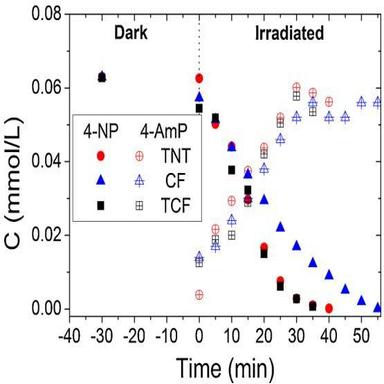
Photocatalytic activity of TNT, CF, and TCF nanocomposites for the reduction of 4-NP to 4-AmP under UV light.